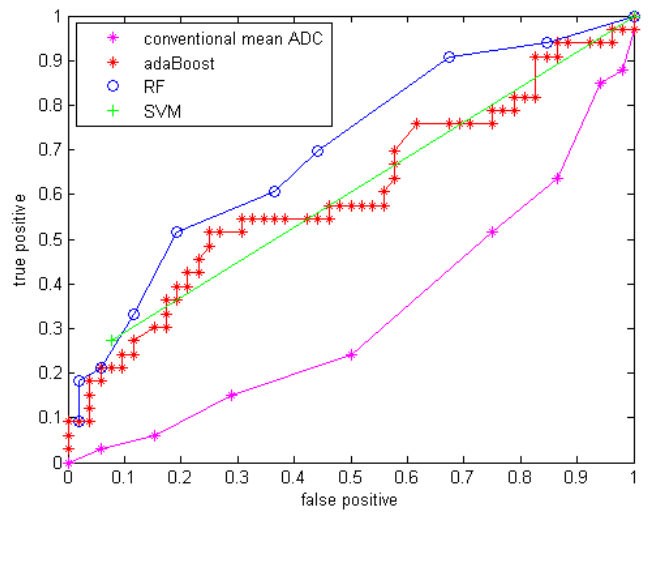
Figure 5. ROC curve for three classifiers with GMM